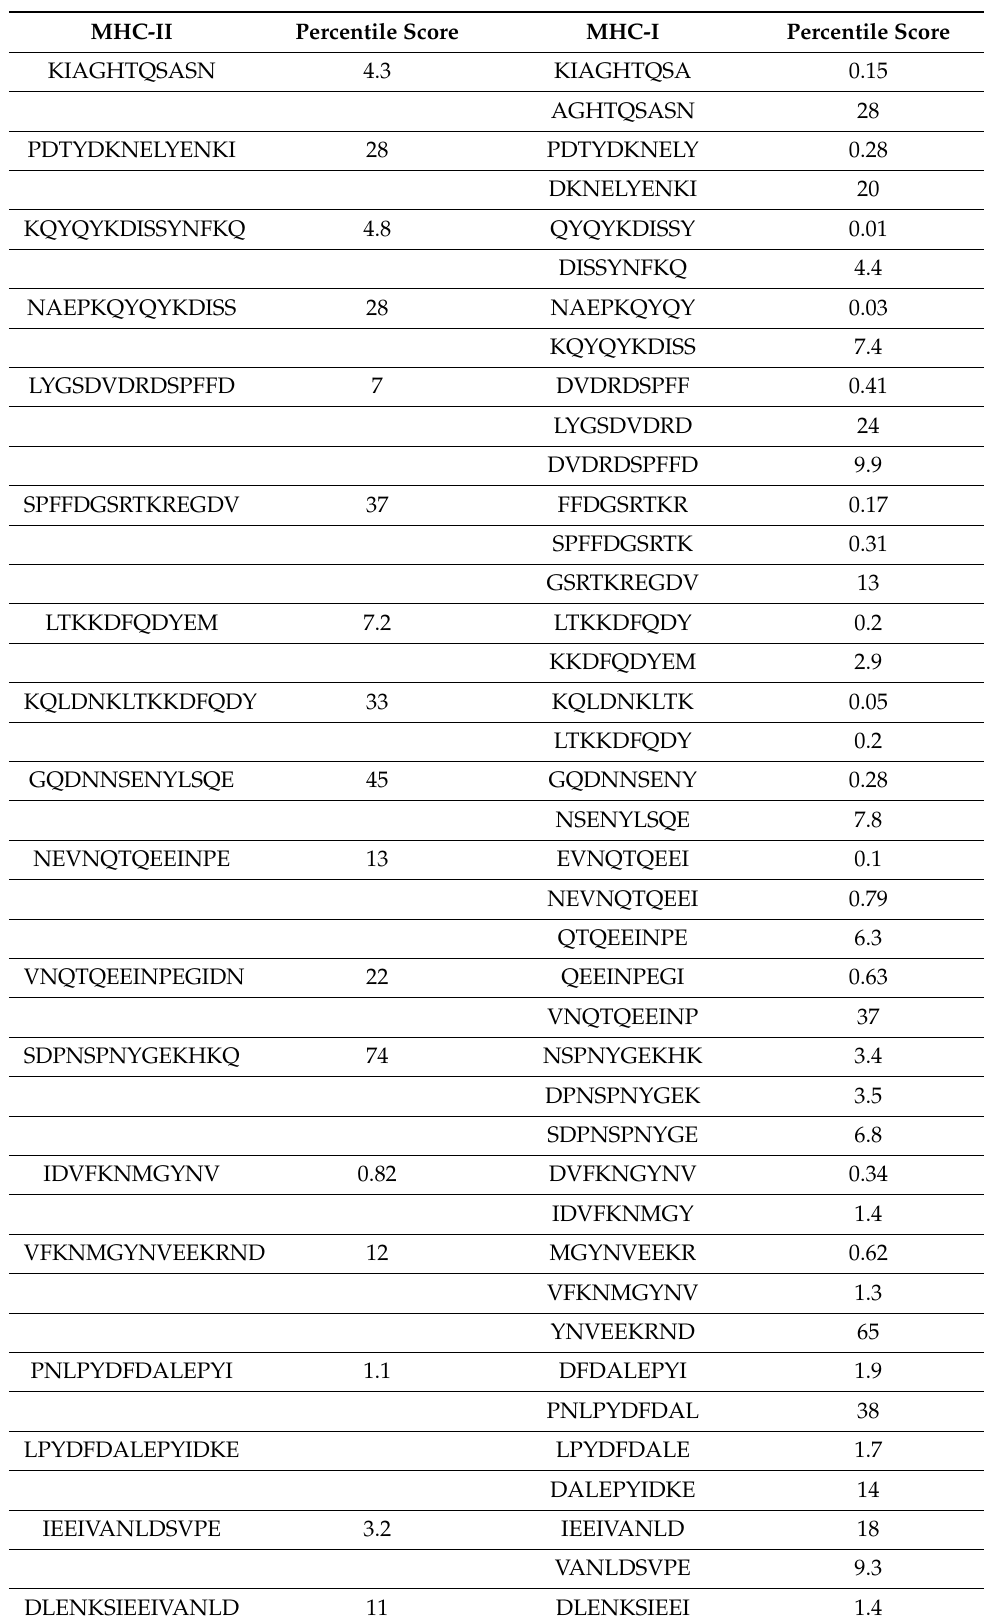
Table 4. MHC-I and MHC-II epitope prediction by B-Cell